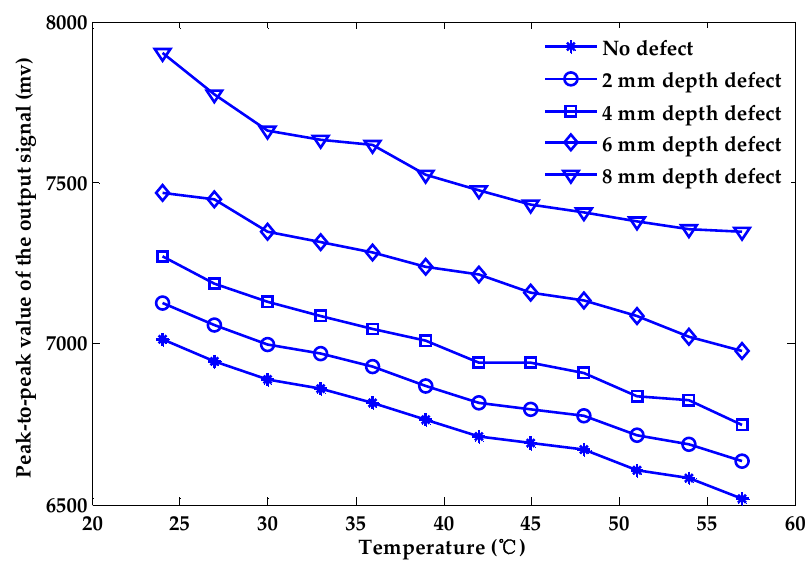
Figure 5. The relationship between the peak-to-peak value of the output signal and the temperature.